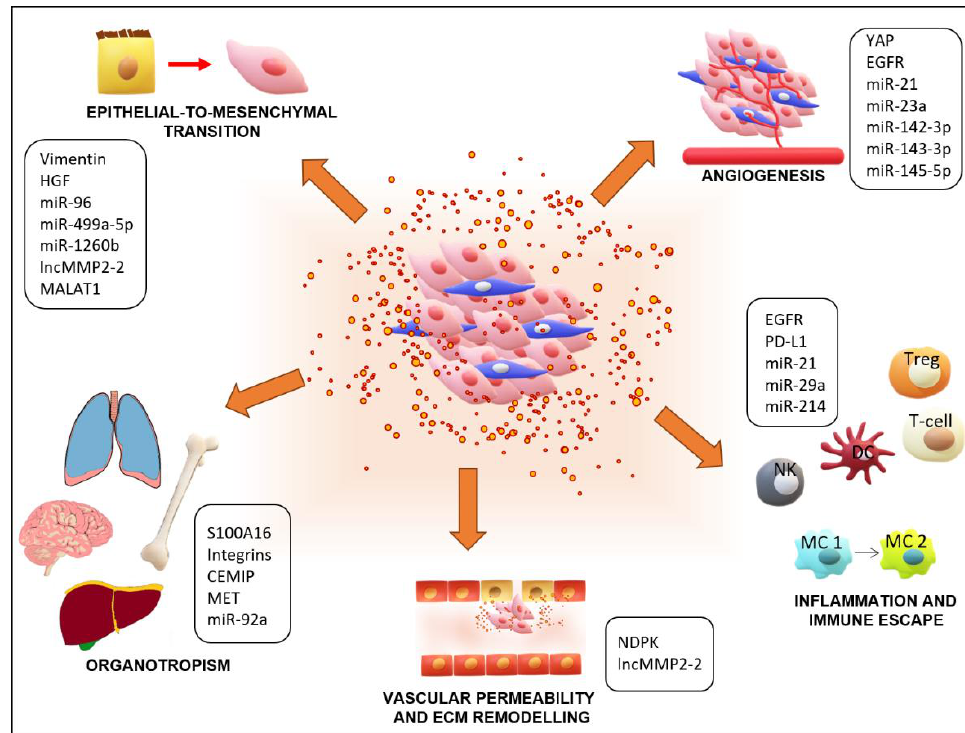
Figure 2. Role of extracellular vesicles (EVs) and their contents in promoting lung cancer metastasis. EVs derived from tumor cells, and other cells of the tumor microenvironment (TME), are involved in every step of the metastatic process of lung cancers. Proteins and RNAs contained in EVs can induce the first steps of metastasis, which are EMT and angiogenesis. Moreover, EVs are implicated in regulating inflammatory responses in the TME, in circulation, and at distant metastatic sites by activating T regulatory cells (Treg), altering properties of dendritic cells (DC), inhibiting the activities of T cells and natural killer cells (NK), and inducing the polarization of macrophages (MC) from type 1 to type 2. At distant sites, EVs are involved in vascular permeability and organotropism by modifying the environment of pre-metastatic niches. Notable EV content that has been shown to contribute to lung cancer metastasis is highlighted for each process.